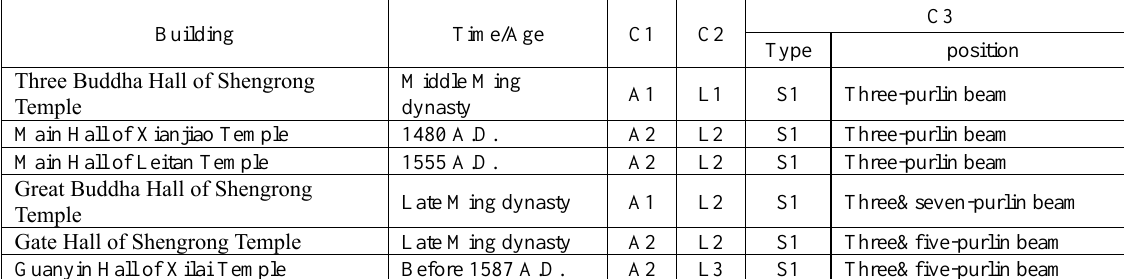
Table.4 typological staging results of the 3